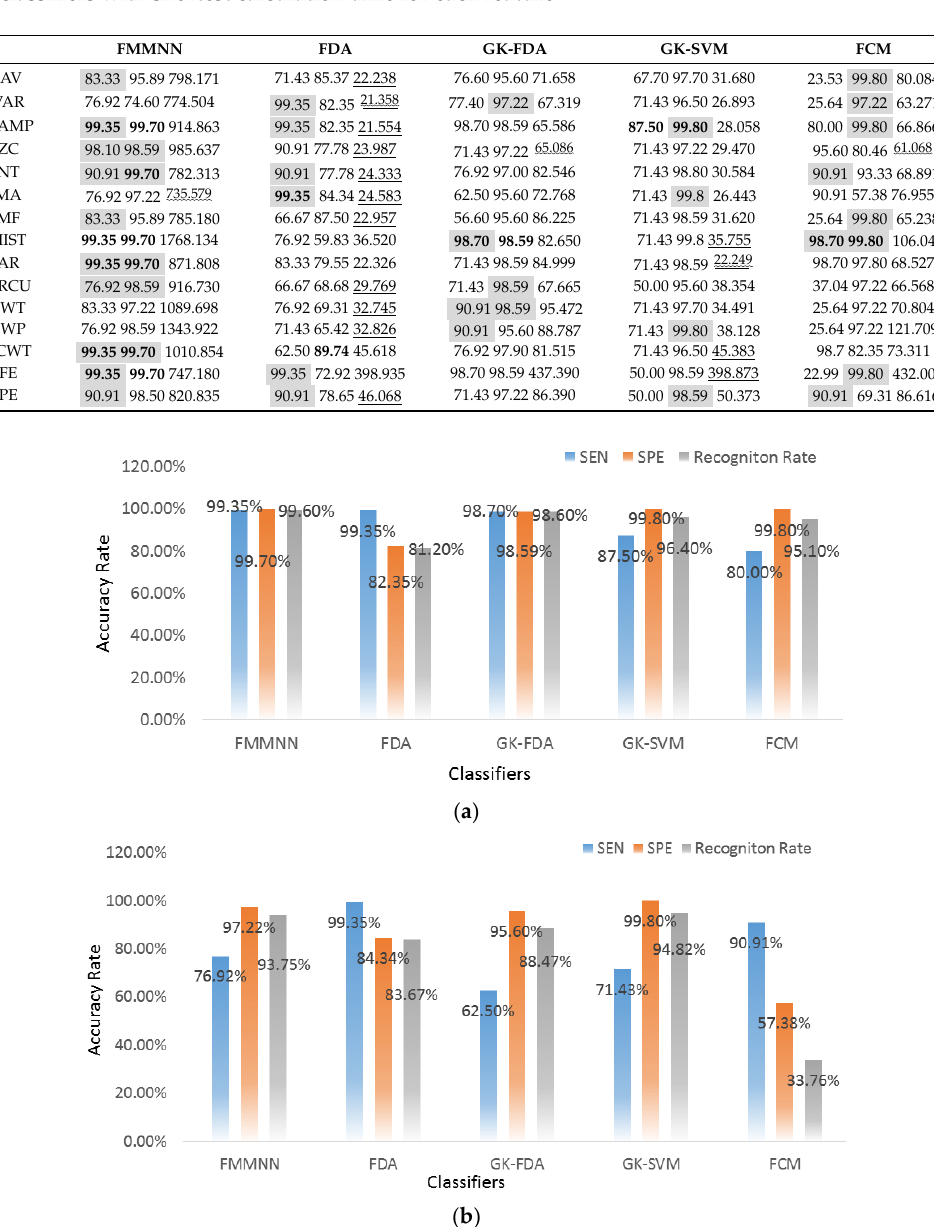
Figure 10. Sensitivity, Specificity, and recognition accurate rate of two specific feature types. ( a ) Sensitivity, Specificity, and whole recognition rate of WAMP. ( b ) Sensitivity, Specificity, and Recognition Rate of MA. Table 4. Sensitivity, Specificity and Calculation times (%, % and ms). The bold numbers indicate the features with highest Sensitivity and Specificity rate for each classifier. The shaded indicate the classifiers with the highest Sensitivity and Specificity rate for each feature. The zigzag underlines indicate the features with shortest calculation time for each classifier. The straight underlines indicate the classifiers with shortest calculation time for each feature.